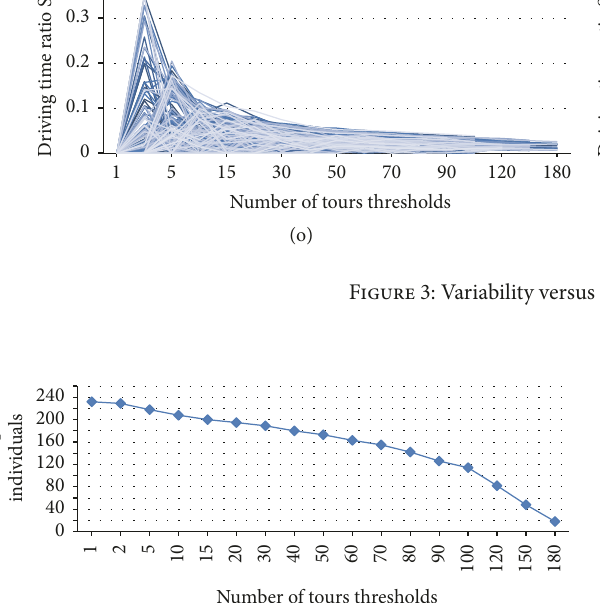
Figure 4: Number of qualified individuals versus number of tours thresholds.